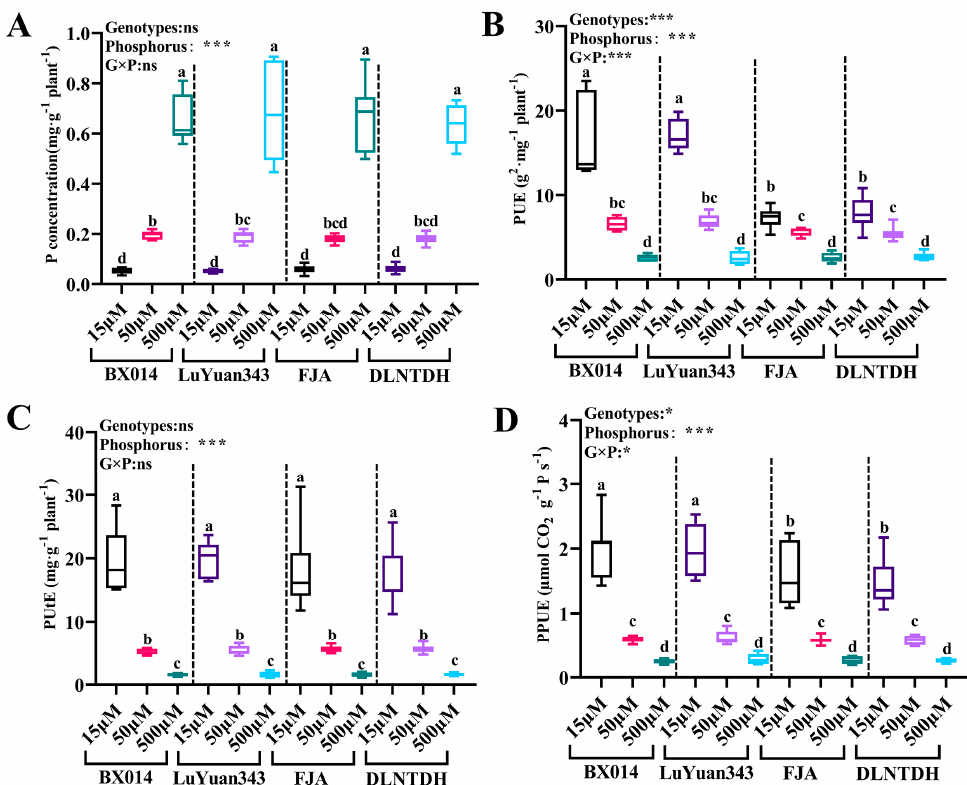
Figure 3. Changes in ( A ) P concentration, ( B ) PUE (P-use efficiency), ( C ) PUtE (P-uptake efficiency), and ( D ) PPUE (Photosynthetic P-use efficiency) in cotton, under different treatments. The results are expressed as means ± SE ( n = 7). Statistically significant changes are indicated by different letters using the two-way ANOVA and multiple-comparison test ( p ≤ 0.05). p -values of the ANOVAs of genotypes (G) , phosphorus level (P), and their interaction (G×P) are indicated as ns, not significant; *: p < 0.05, ***: p < 0.001.